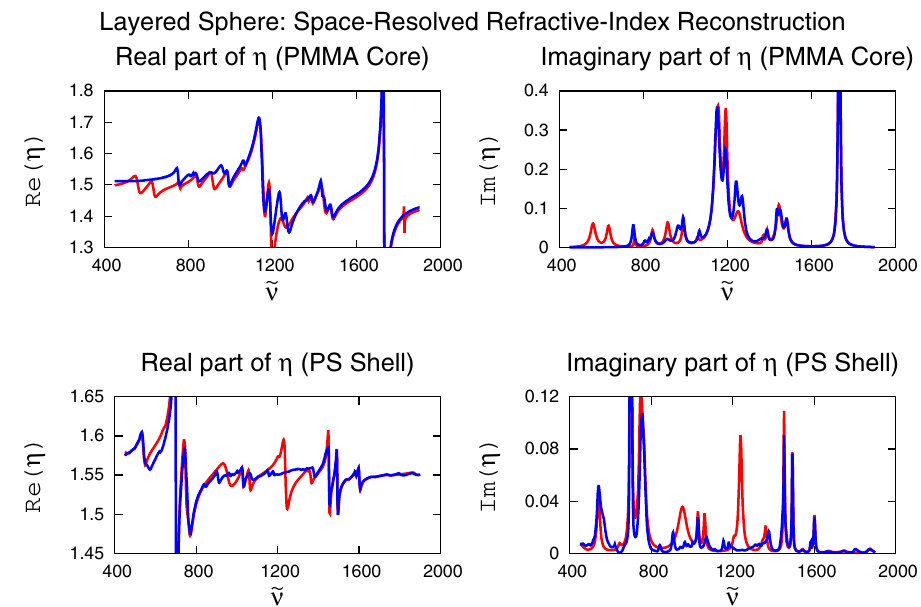
Figure 4. Reconstructions of real and imaginary parts of the complex refractive index η( ˜ ν) (blue lines) for a layered sphere consisting of PMMA in the core and PS in the shell. 18 Lorentzians were used for the PMMA reconstructions and 22 Lorentzians were used for the PS